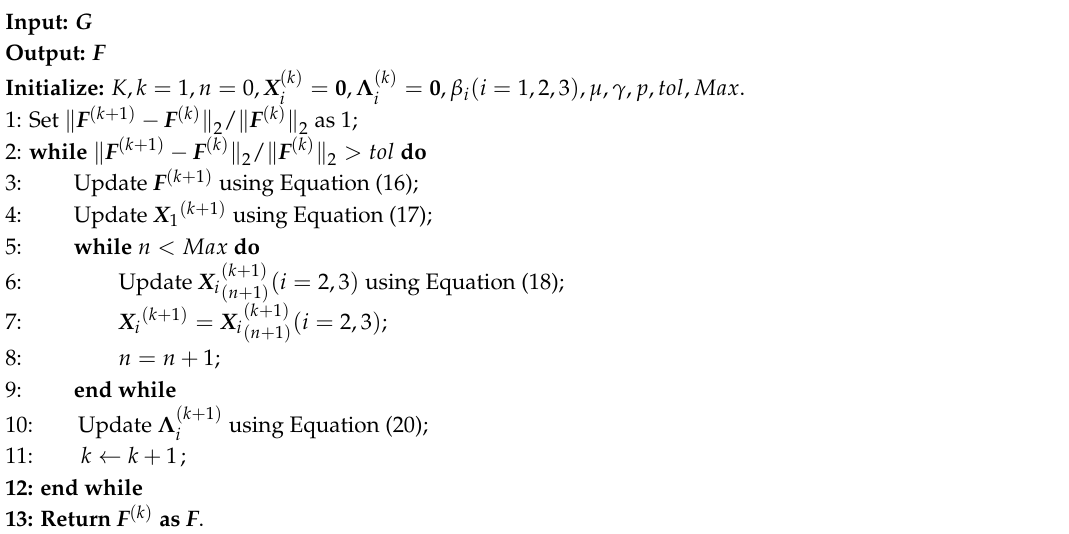
Algorithm 1 : Pseudocode GGS_Lp for image